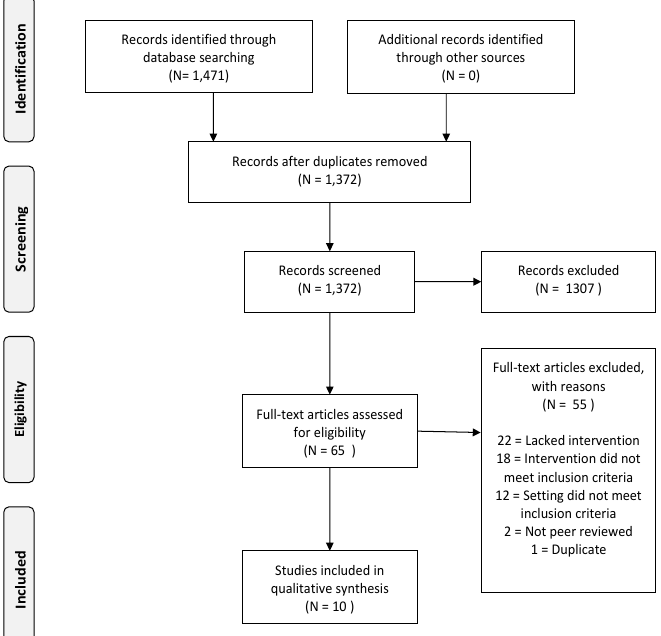
Figure 1. PRISMA flow diagram. PRISMA, Preferred Reporting Items for Systematic Reviews and Meta-Analyses; TIC, trauma-informed care.